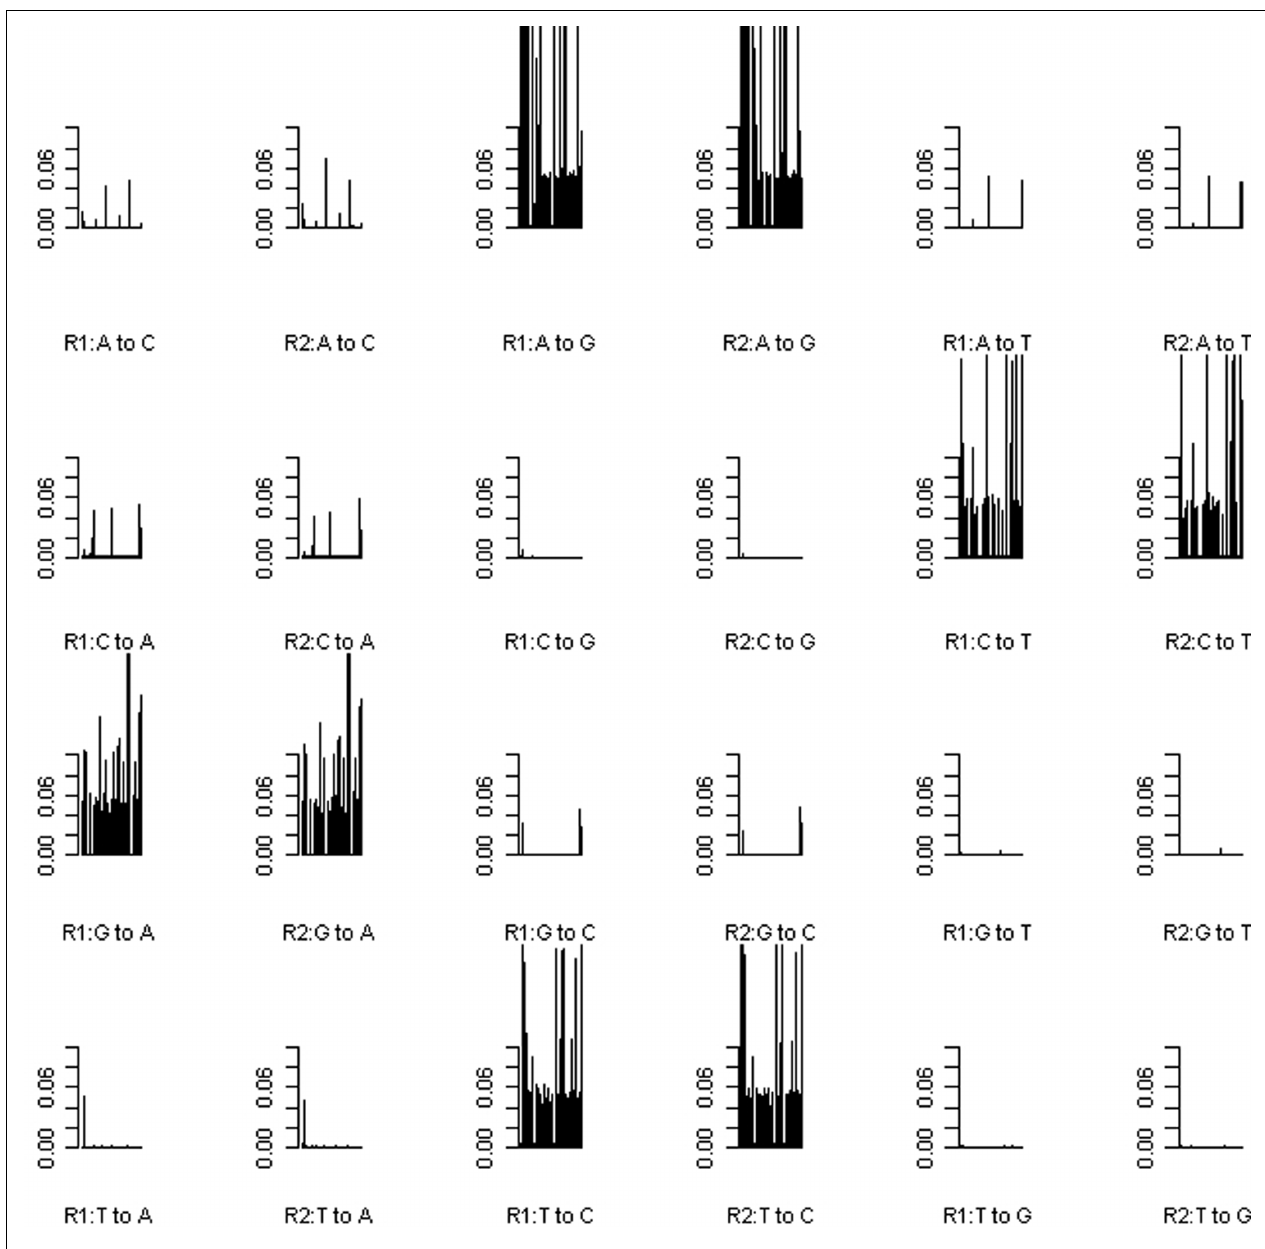
FIGUREA2 | Position-specific base-calling error rates for Post-PCR.